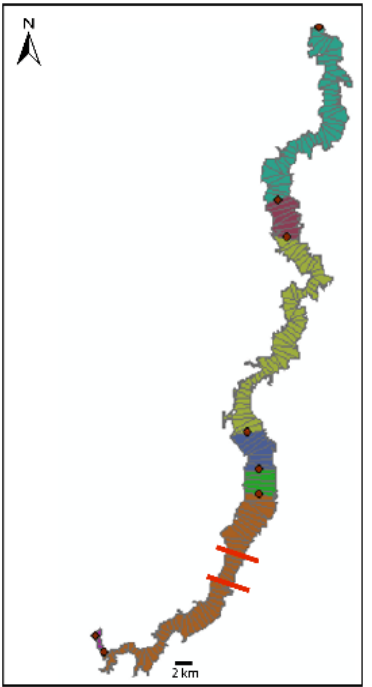
Figure 3. Example of segmentation of a continuous, quantitative attribute (the VB width of a stretch of the Magdalena River) via Hubert statistical test as implemented in the Fluvial Corridor Toolbox: the output (stretches of different colors) is questionable (see text).